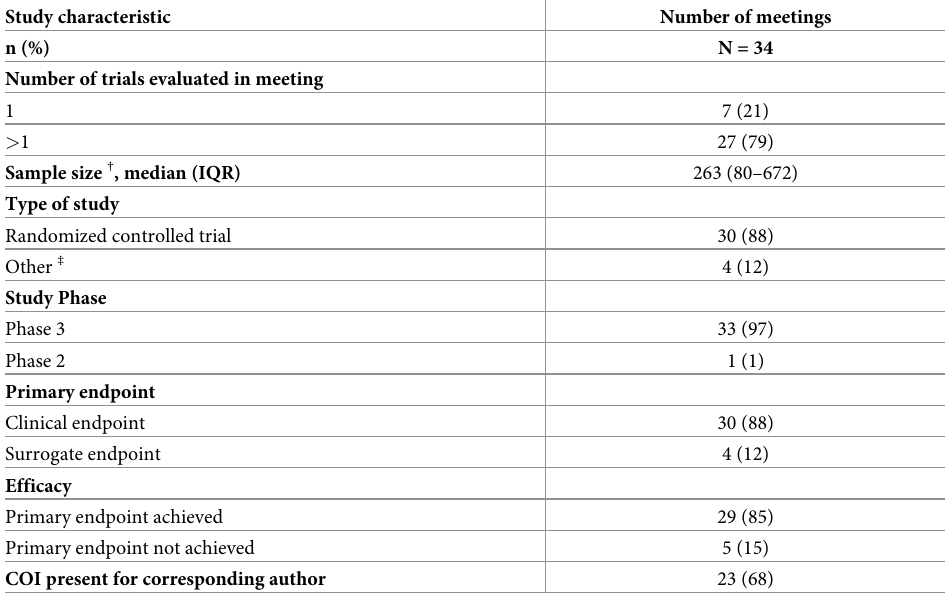
Table 3. Characteristics of studies evaluated for drug applications.